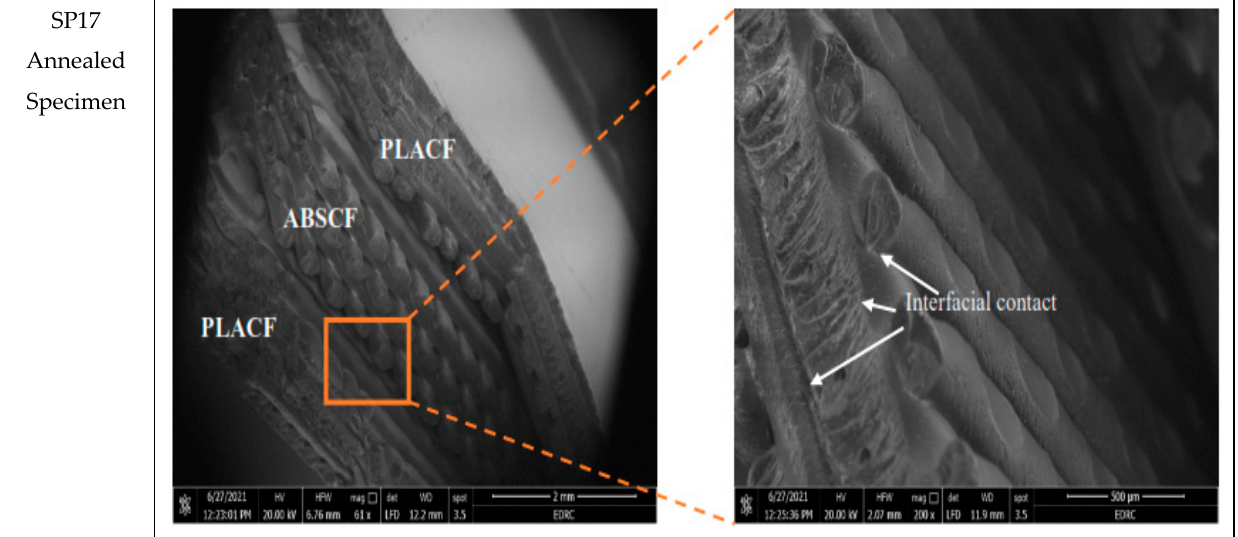
Figure 11. SEM photos for the effect of heat treatment over SP17sample.